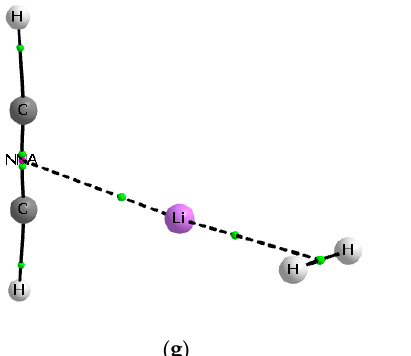
Figure 1. Molecular graphs of selected complexes analyzed in this study; ( a ) C 2 H 3+ ‐ C 2 H 2 , ( b ) C 2 F 2 H + ‐ C 2 F 2 , ( c ) C 2 H 2 Li + ‐ C 2 H 2 , ( d ) C 2 H 2 Li + ‐ C 2 F 2 , ( e ) C 2 H 3+ ‐ H 2 , ( f ) C 2 F 2 H + ‐ H 2 , ( g ) C 2 H 2 Li + ‐ H 2 , ( h ) C 2 Li 3+ ‐ H 2 . Big circles correspond to attractors, small green circles to bond critical points, small red circles to ring critical point (in ( d ), the C 2 H 2 Li + ‐ C 2 F 2 complex) and to non ‐ nuclear attractors (NNAs). The continuous and broken lines correspond to bond paths.